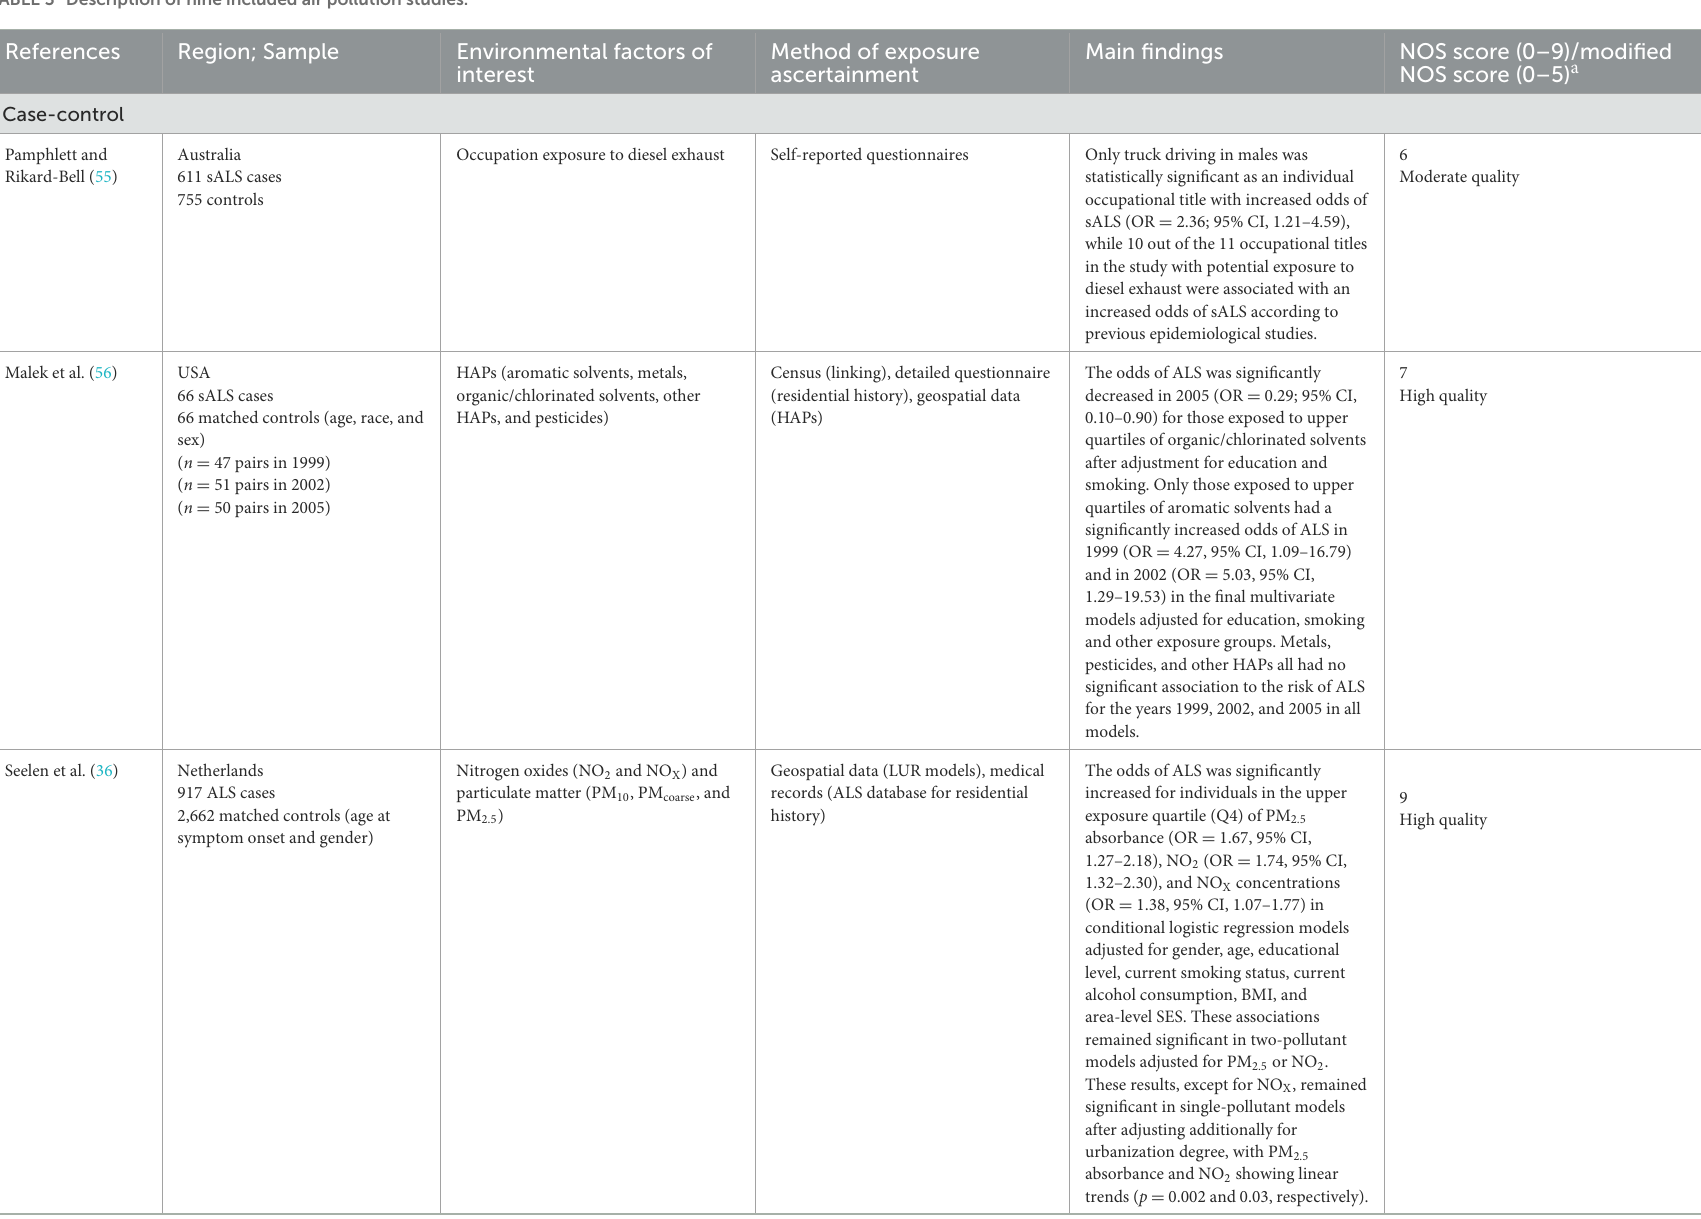
TABLE 3 Description of nine included air pollution